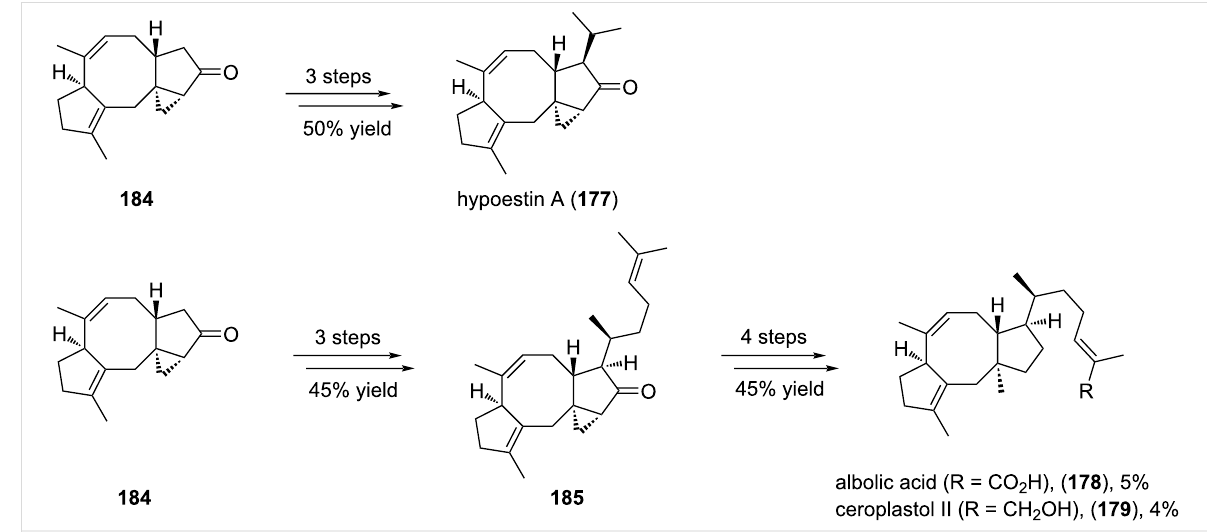
(Scheme 37). For the synthesis of hypoestin A ( 177 ), the side chain was introduced by selective deprotonation of 184 , addi- tion of acetaldehyde, dehydration and conjugated addition of Me 2 CuLi. These three last steps provided the desired product 177 in 50% overall yield. For the synthesis of albolic acid ( 178 ) and ceroplastol II ( 179 ), the side chain was introduced by de- protonation and addition of the corresponding aldehyde. After dehydration of the subsequent alcohol and conjugated addition of Me 2 CuLi, the regioselective reductive opening of cyclo- propane 185 was performed with lithium in liquid ammonia in order to introduce the angular methyl group. In the same time, the ketone was reduced into an alcohol, which one was submitted to Barton deoxygenation. The alkene side chain underwent a metathesis reaction with methyl methacrylate to introduce an ester. Finally, this latter was hydrolyzed or reduced to respectively provide albolic acid ( 178 ) and ceroplastol II ( 179